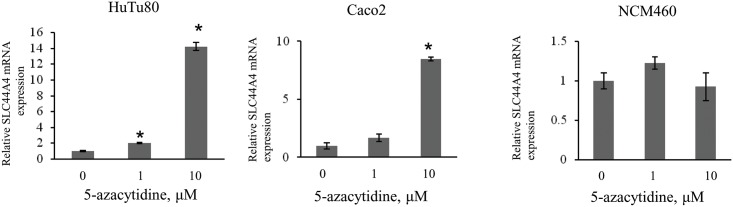
Effect of 5-azacytidine on the SLC44A4 mRNA expression.Cells were treated with 5-azacytidine (0, 1, and 10 μM) for 48 hrs followed by RNA isolation and quantitative RT-PCR analysis. Results, normalized relative to β-actin, are presented as fold increase compared to untreated control (set as 1). Data are means ± SE from three independent experiments. *P < 0.05.